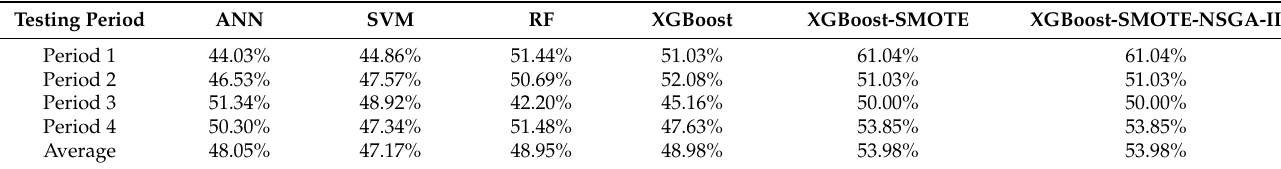
Table 5. Hit ratio results for rebar futures price direction